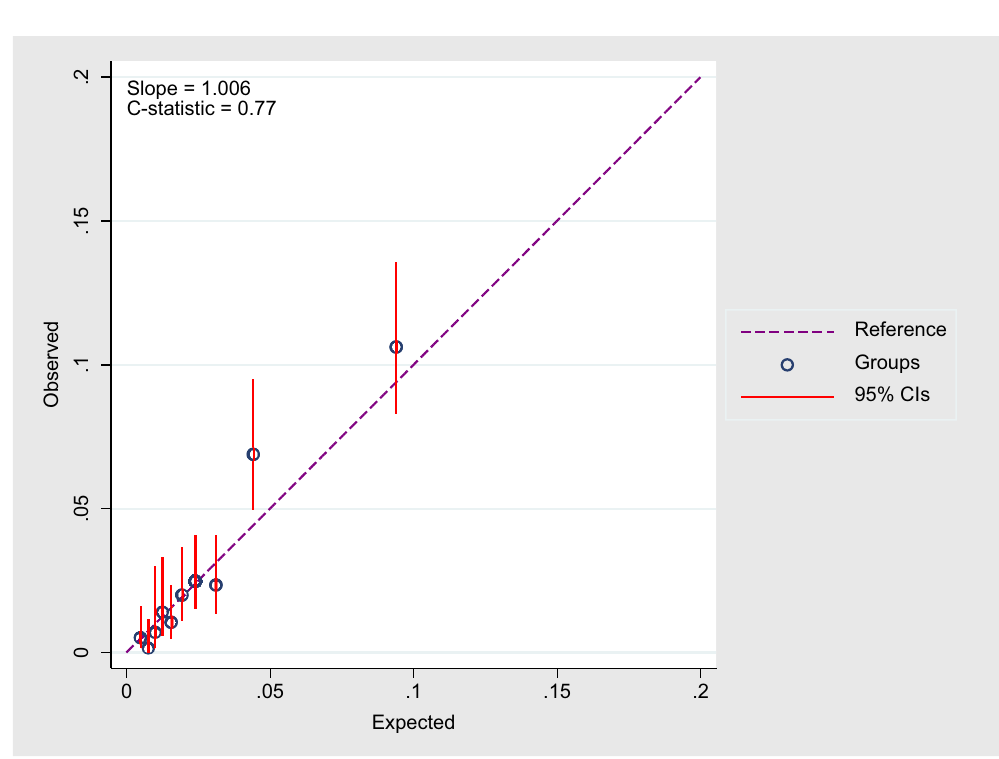
Slope = 1.006 C-statistic = 0.77